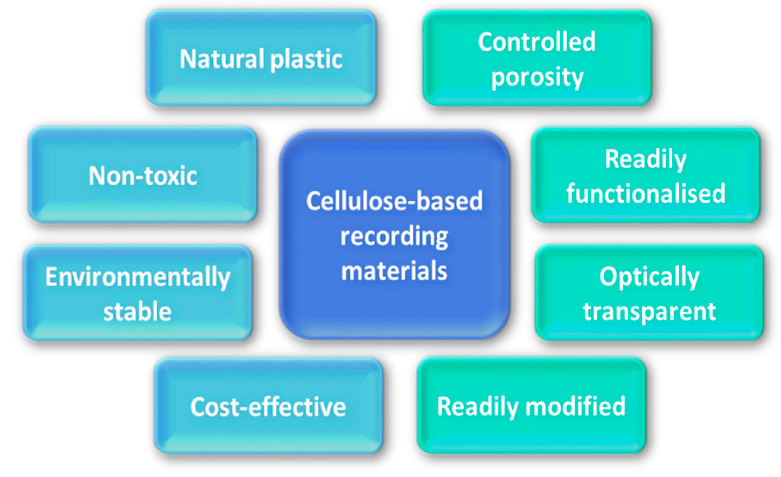
Figure 2. Key advantages of cellulose as a binder.